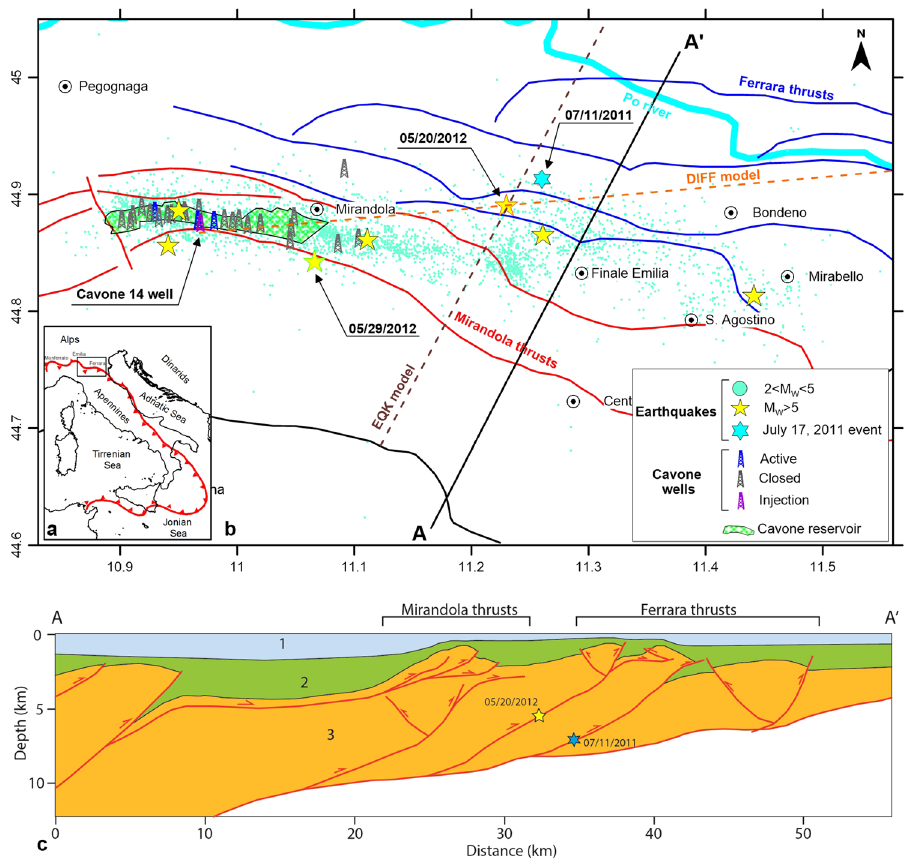
Figure 1. ( a ) Main thrust alignment in Italy. ( b ) Detailed map of the study area (black box in panel a). Location of the 2012 Emilia seismic sequence with respect to the Cavone oilfield and the production/injection wells. The yellow stars are earthquakes larger than M L > 5.0. The two mainshocks are represented by yellow stars with red (05/20/2012 event) and green (05/29/2012 event) outlines. The cyan star indicates the position of the July 17, 2011 event. The tectonic structures represent the main thrusts (continuous lines) and back-thrusts (dashed lines) of the Ferrara (blue), Mirandola (red) and Pede-Apennines (black) systems 75 . The orange and brown dashed lines represent the cross sections of the DIFF and EQK models, respectively. ( c ) Simplified geological cross-section of A-A’ in panel b. The units in this section are as follows: 1- Quaternary layer, 2- Pliocenic- Miocenic layer, and 3- Triassic-Lower Cretaceous layer. This figure was created with Surfer ® from Golden Software, LLC (www.goldensoftware.com) and Adobe Illustrator